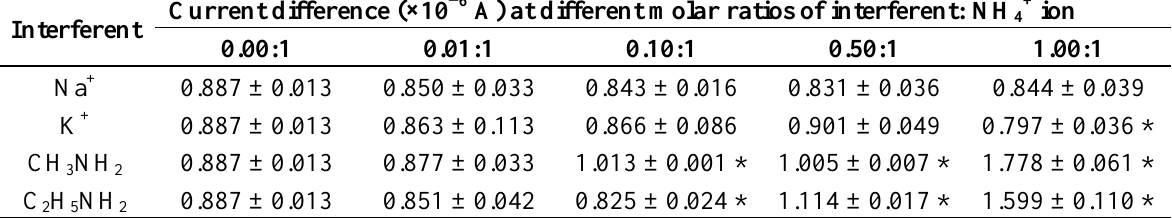
NH and C H NH at different molar ratios to 3 2 2 5 2